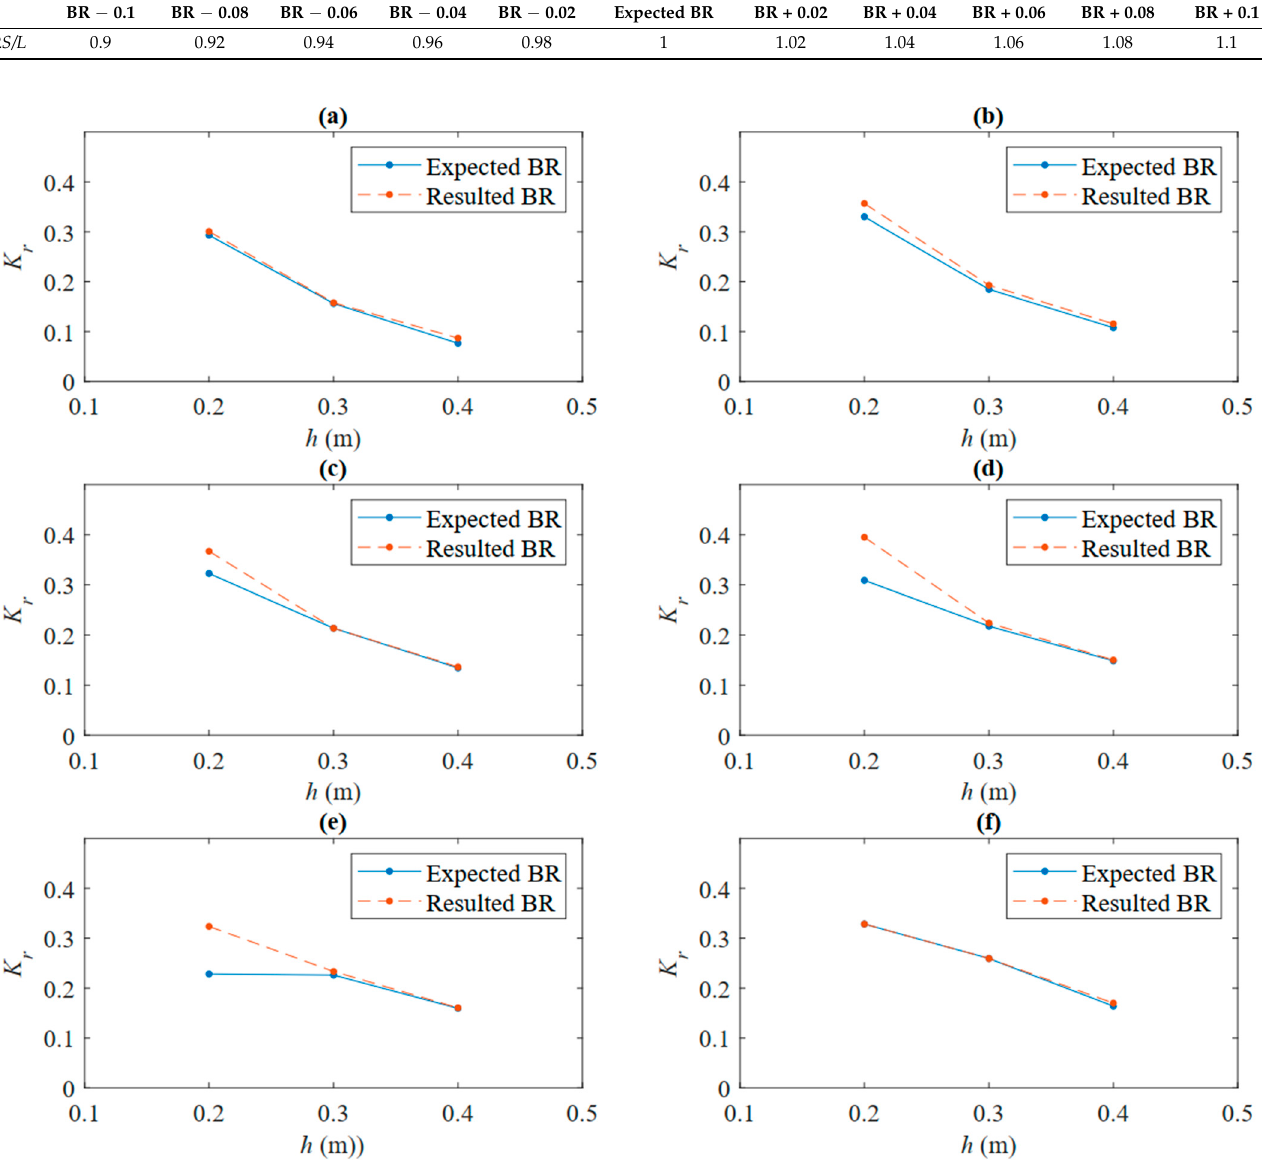
Figure 9. Bragg resonance of 2 periodically submerged breakwaters along different structural wave- lengths at different water depths: ( a ) S = 1.0 m ( b ) S = 1.2 m ( c ) S = 1.4 m ( d ) S = 1.6 m ( e ) S = 1.8 m ( f ) S = 2.0 m.